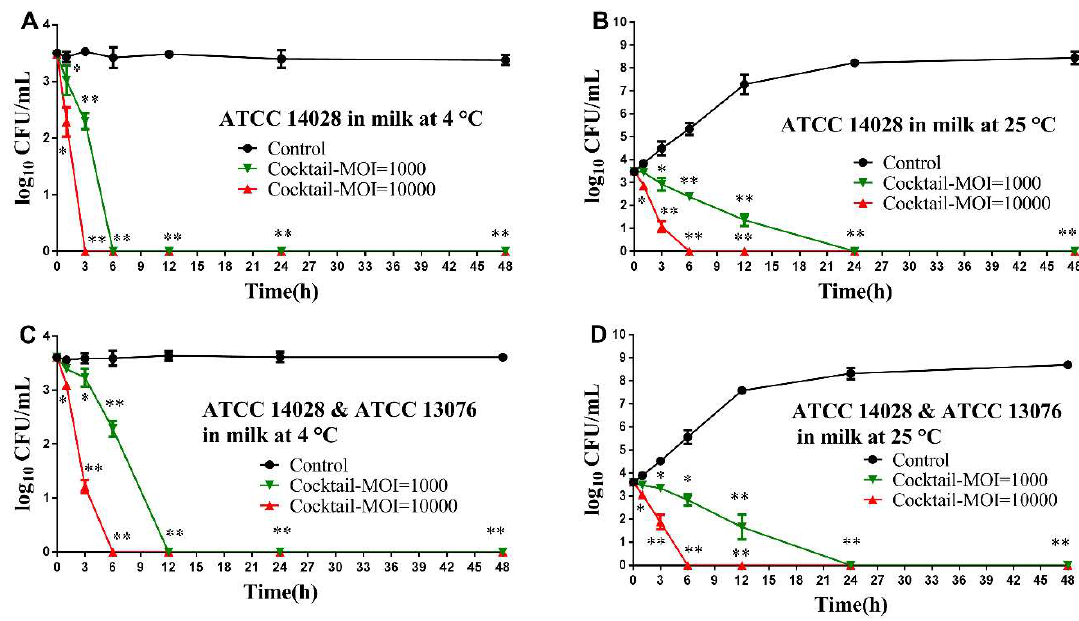
Figure 4. E ff ectiveness of phage cocktail in reducing the S. Typhimurium ATCC 14028 and S. Enteritidis ATCC 13076 in milk. ( A ) E ff ect of phage cocktail on growth of S. Typhimurium ATCC 14028 in milk at 4 ◦ C; ( B ) E ff ect of phage cocktail on growth of S. Typhimurium ATCC 14028 in milk at 25 ◦ C; ( C ) E ff ect of